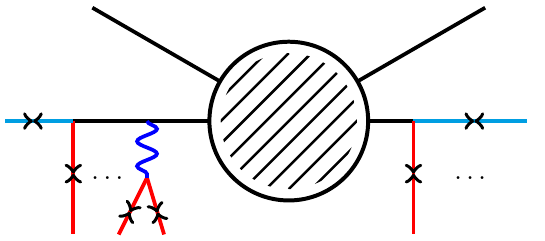
Figure 8 . Feynman diagram for multiple soft gravitini | II.